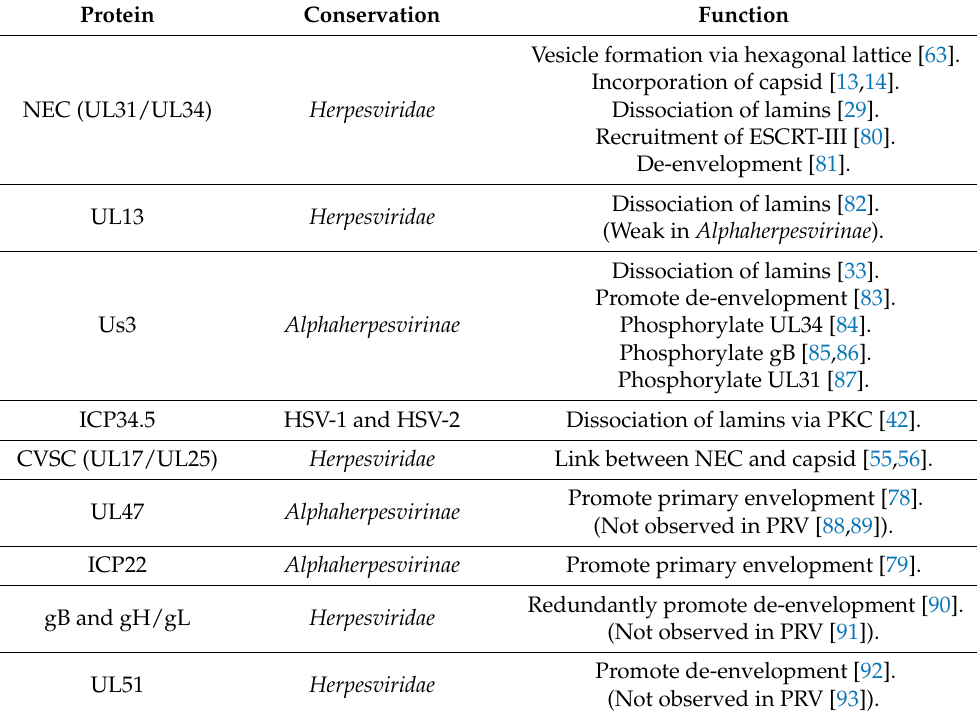
Table 1. Viral factors involved in nuclear egress of HSV capsid.